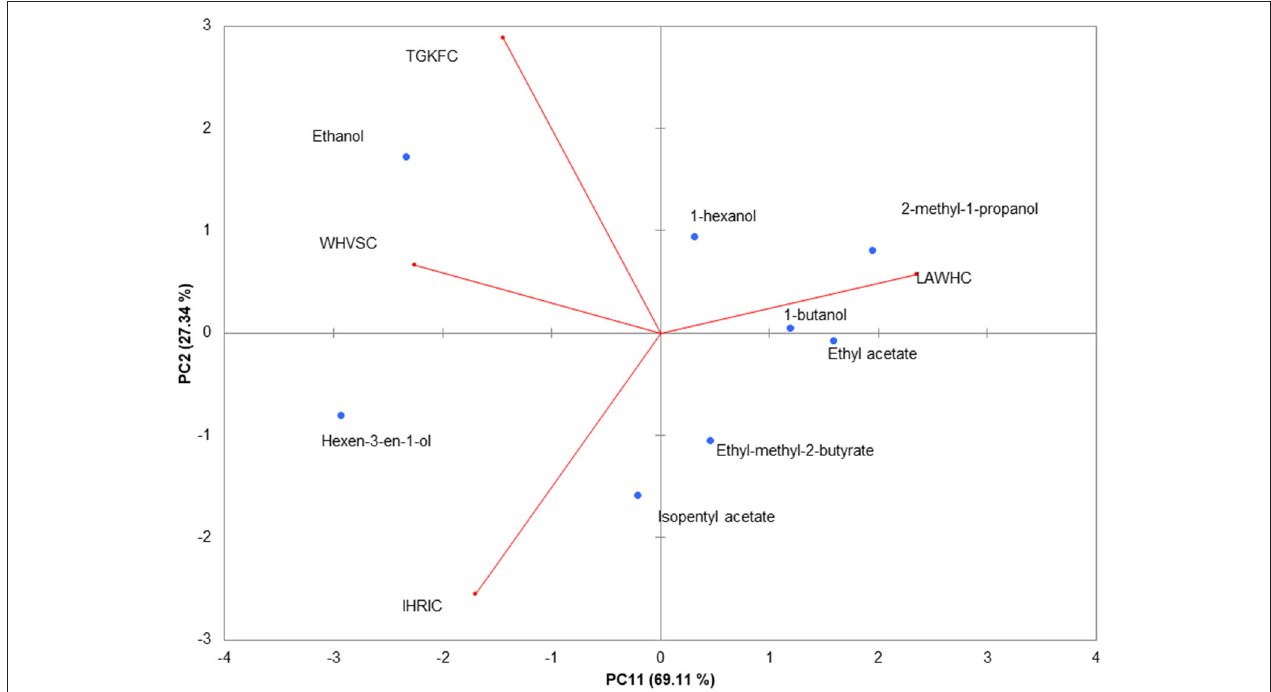
FIGURE 3 | PCA of the piezoelectric response. The biplot (Score and loading) of the first two principal components showed 94.45% of the cumulative variance. Rows normalization were applied to the gas sensors array dataset. Data were autoscaled before PCA.